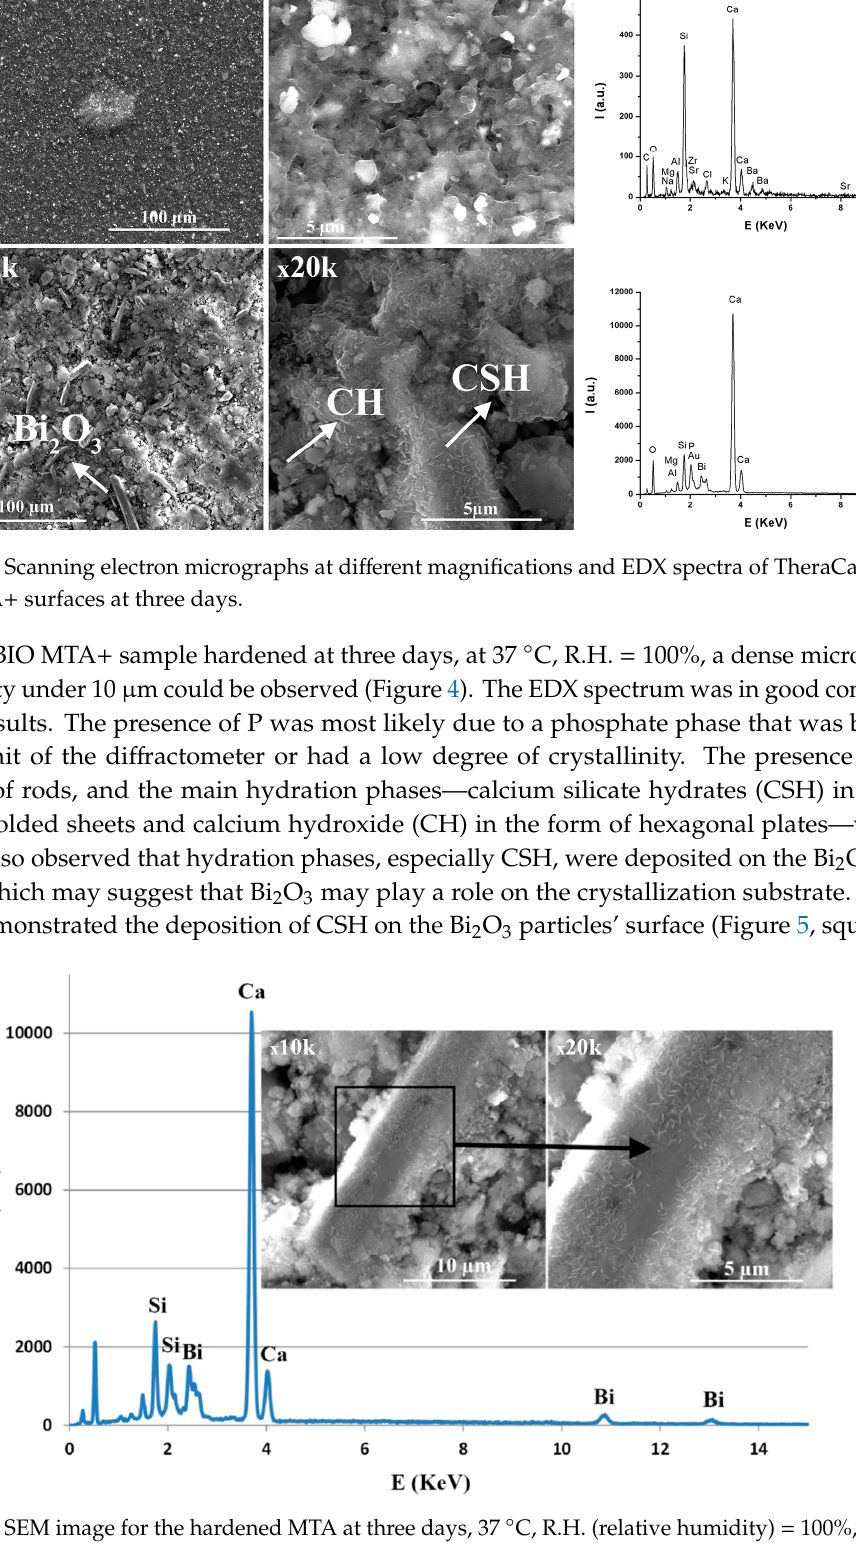
Figure 5. SEM image for the hardened MTA at three days, 37 °C, R.H. (relative humidity) = 100%, with detail on the Bi 2 O 3 particle and characteristic EDX spectra . detail on the Bi 2 O 3 particle and characteristic EDX